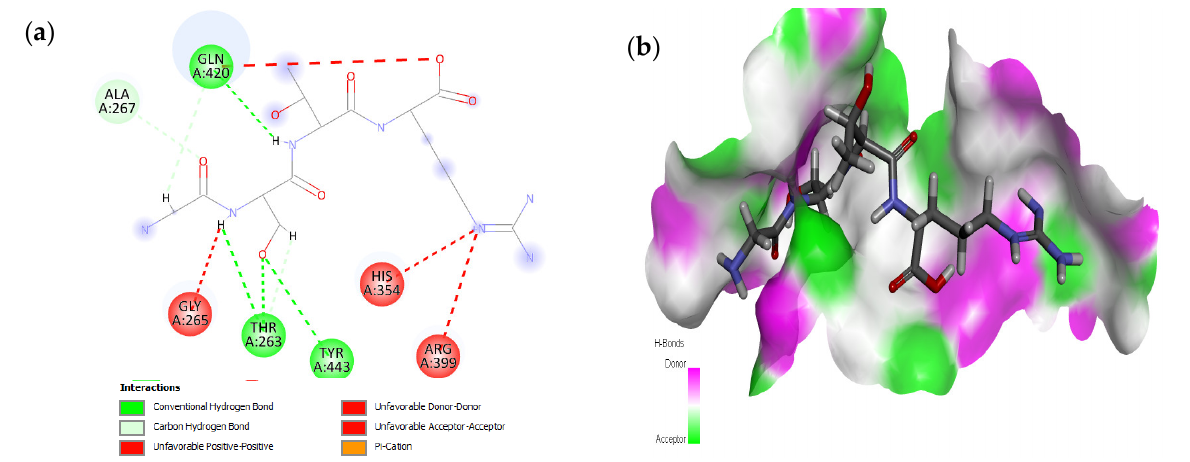
Figure 1. Interaction ( a ) and binding pattern ( b ) of GSTR peptide with ORF2 (capsid protein) with HEV as receptor.